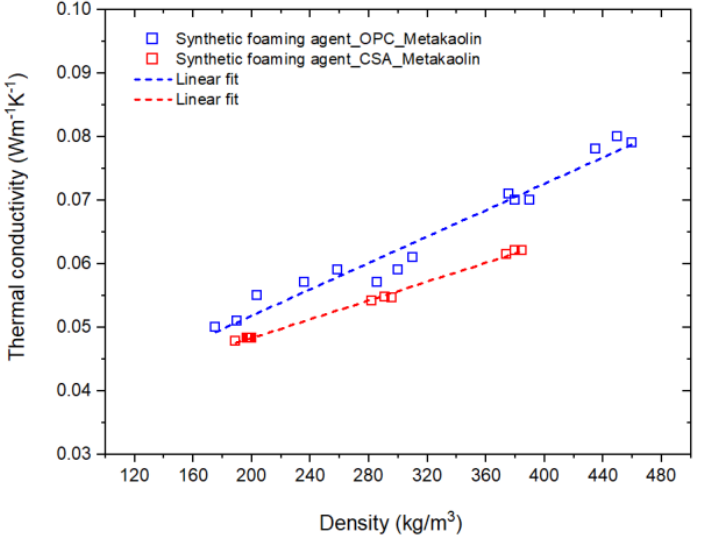
Figure 15. Thermal conductivity of foam concrete made of synthetic foaming agent with OPC or CSA and metakaolin.